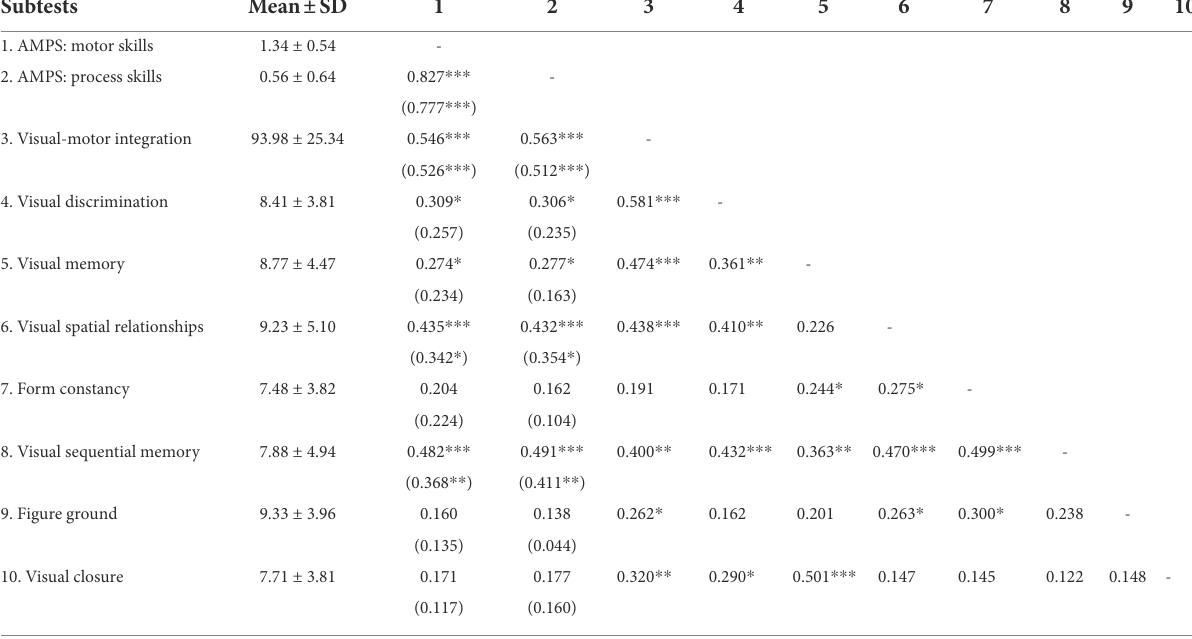
TABLE 1 Mean scores and coefficients of self-care and visual perception subtests ( n =